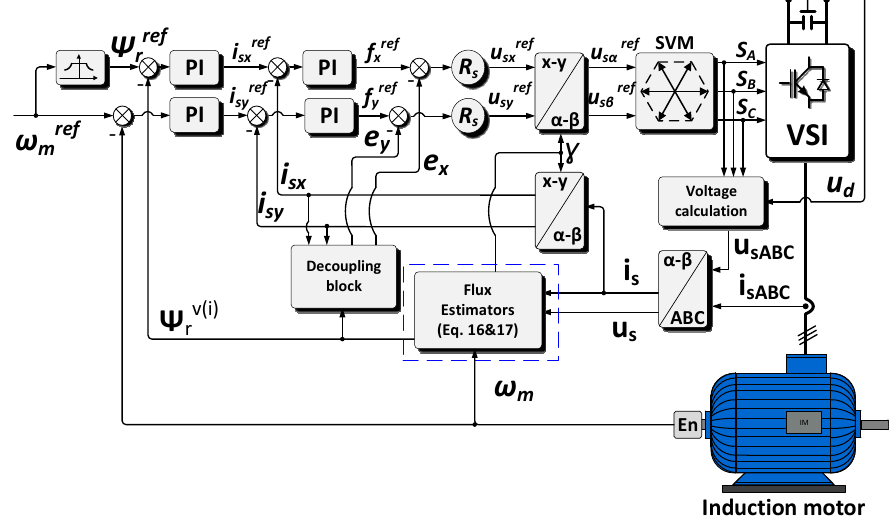
Figure 3. Direct field-oriented control structure.